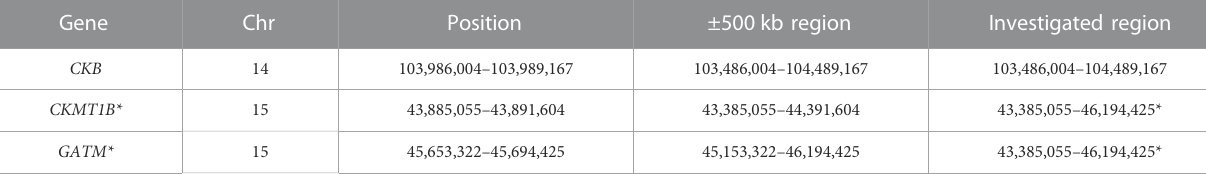
TABLE 1 Genomic positions investigated in the sex-strati fi ed analyses. Since CKMT1B and GATM are located in close proximity, these two genes were investigated collectively within one region (*). The analyzed regions refer to GRCh37, as all GWAS data were exclusively available for this genome version.